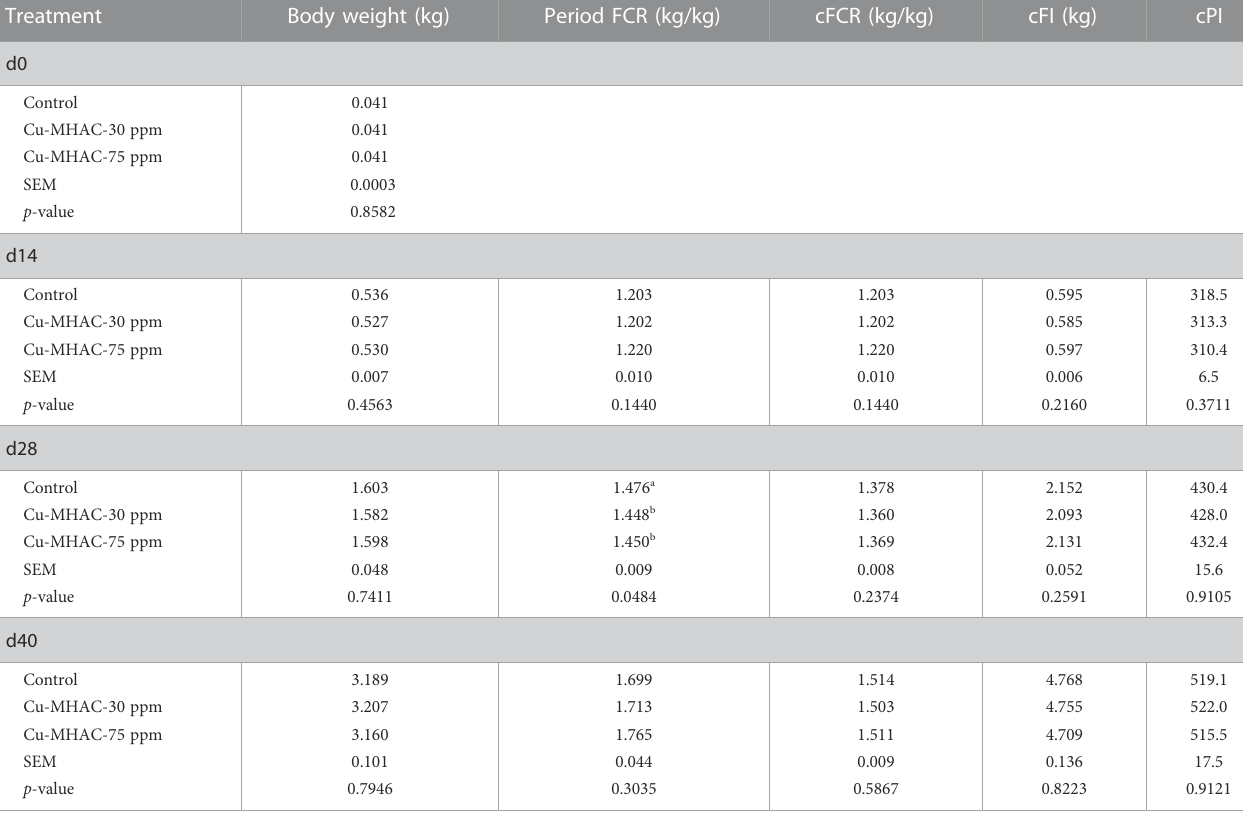
TABLE 6 Growth performance of broilers in experiment #1.